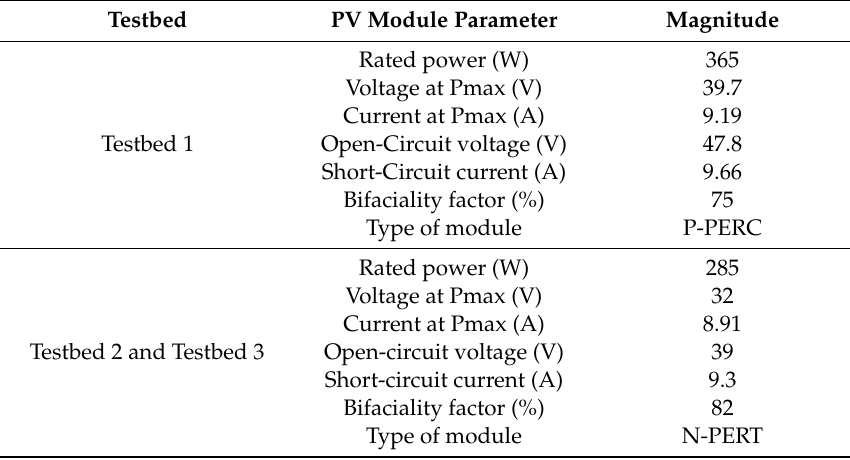
Table 2. Specification of the bifacial PV module at each